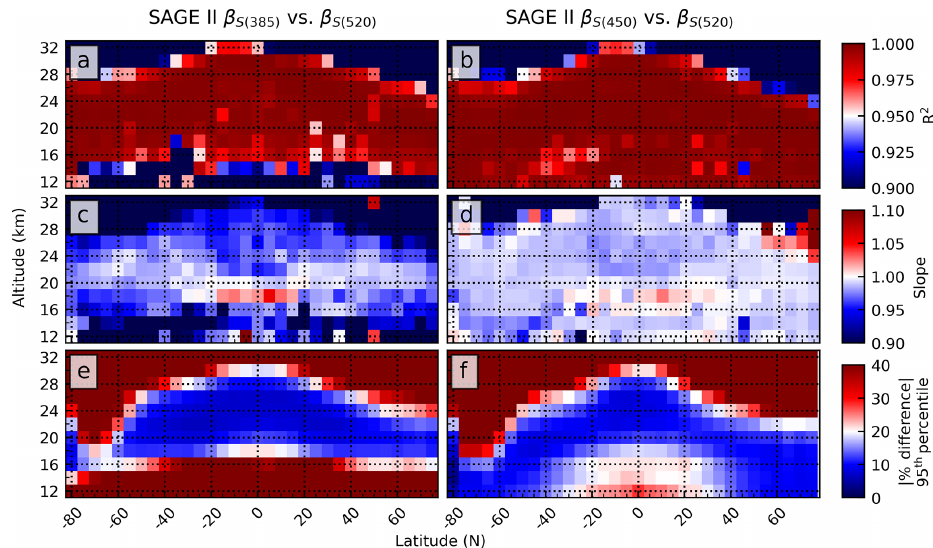
Figure 4. Zonal statistics displaying the overall agreement between the two backscatter calculations using data collected during the SAGE II mission. Panels (e) and (f) show the 95th percentile of the absolute value for the percent difference.